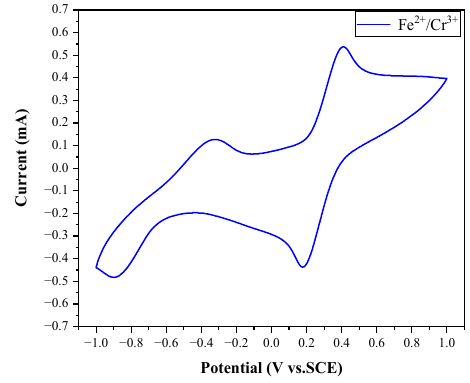
Figure 2. CV plot of Fe 2+ -Cr 3+ electrolyte. The redox processes of Fe 2+ /Fe 3+ and Cr 2+ /Cr 3+ redox pairs in the SRFB are summarized in Equations (2)–(4) as follows: